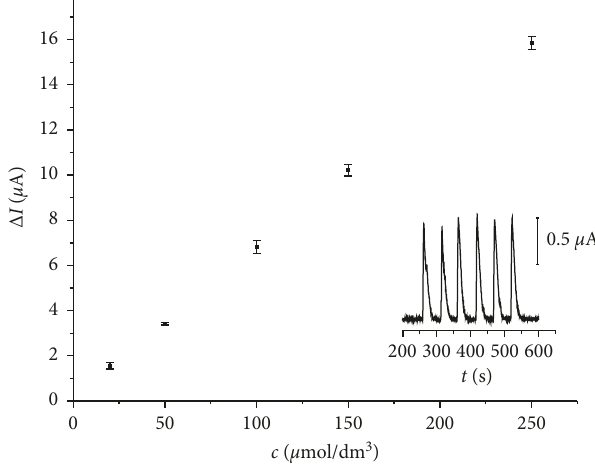
Figure 4: Linear response for FIA-DPA system for 20–250 µ mol/dm 3 diazepam. Inset: six consecutive injections of 100 µ mol/dm 3 of